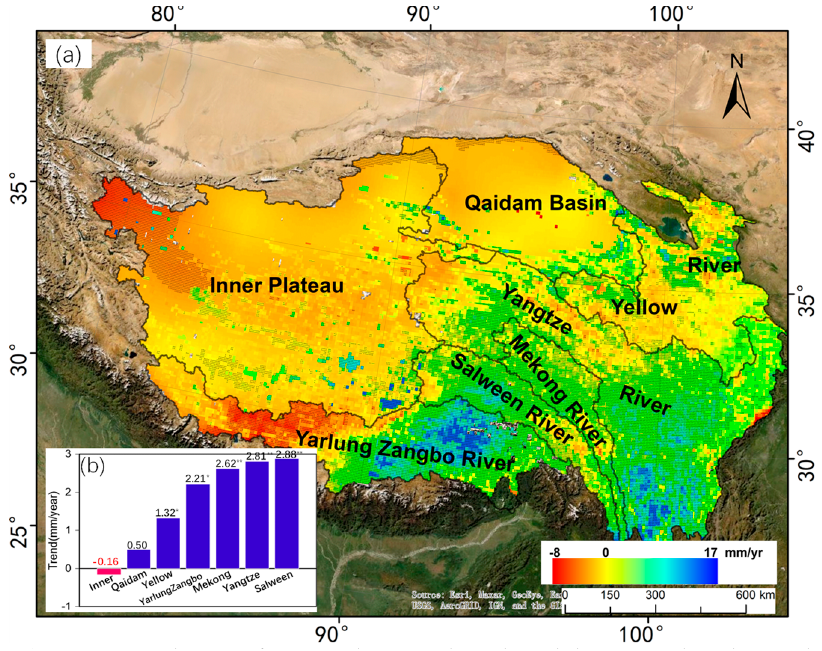
Figure 10 Distribution of corrected ET trends in the sub ‐ basins on the Tibetan Plateau. ( a ) The spa ‐ Figure 10. Distribution of corrected ET trends in the sub-basins on the Tibetan Plateau. ( a ) The spatial tial distribution of corrected ET trends, s tippling denotes regions where the trend is significant at distribution of corrected ET trends, stippling denotes regions where the trend is significant at the the 90% level ( p < 0.1, t − test). ( b ) The statistics of corrected ET trends in each sub ‐ basin. The * rep ‐ 90% level ( p < 0.1, t -test). ( b ) The statistics of corrected ET trends in each sub-basin. The * represents resents p < 0.1, and ** represents p < 0.05. p < 0.1, and ** represents p <